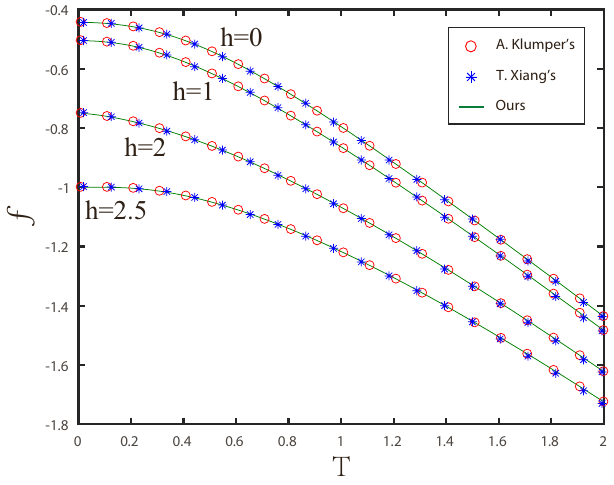
Figure 2 . Free energy f vs T for the closed XXX chain in different magnetic